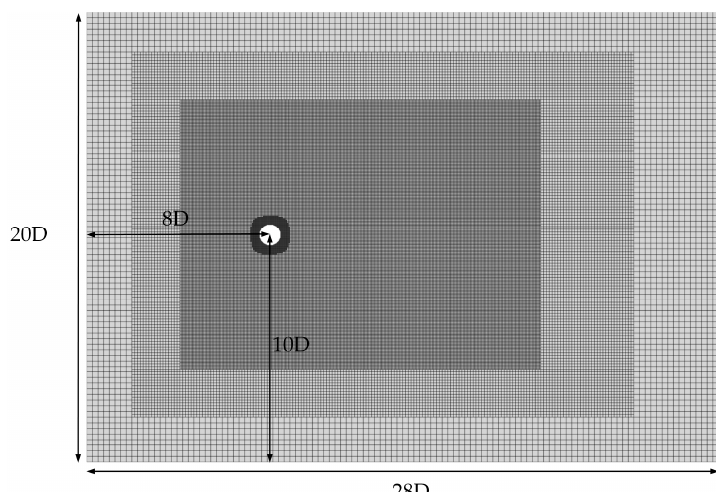
Figure 14. Schematic diagram of the four-level grid around the cylinder in 2D case. The accuracy of the multi-level grid MRT-LBM is verified by drag coefficient 𝐶 (cid:3005) , lift coefficient 𝐶 (cid:3013) and Strouhal number 𝑆𝑡 .